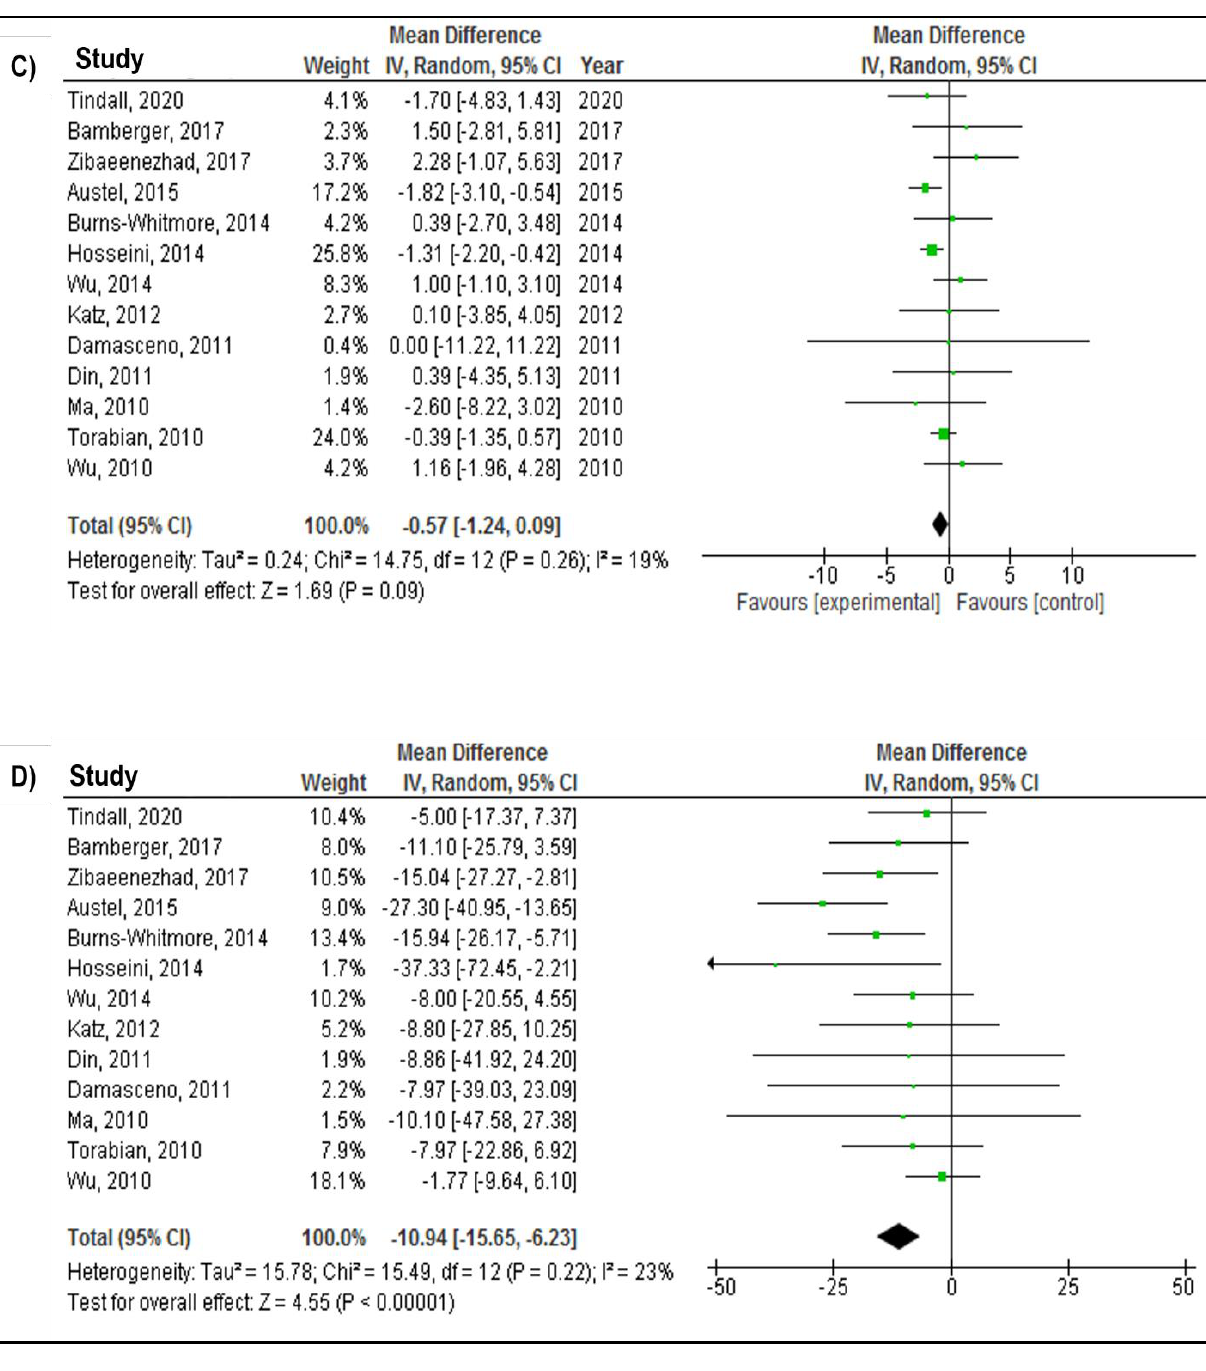
Figure 3. Forest plot presenting mean difference (MD) and 95% confidence intervals for the effect of walnut consumption on ( A ) TC (mg/dL), ( B ) LDL − C (mg/dL), ( C ) HDL − C (mg/dL), and ( D ) TG (mg/dL).[34